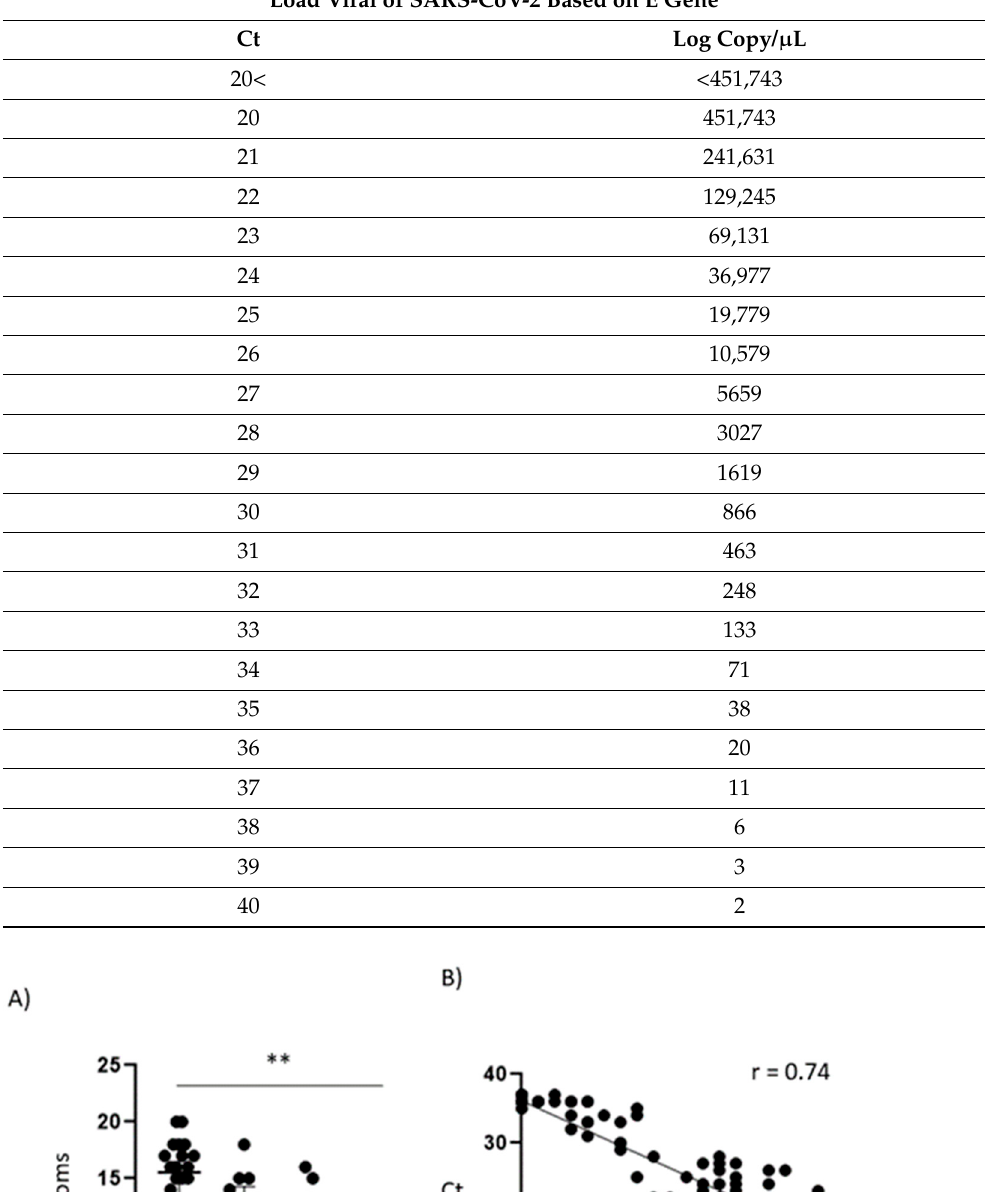
Table 2. Value of cycle threshold (Ct) and relationship with the viral load of SARS-CoV-2 based in Gene E.